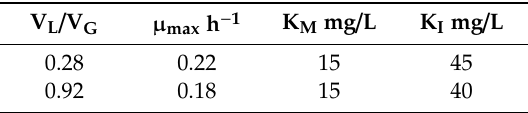
Table 3. Kinetic parameters assessed by the regression of experimental data, according to the proposed model (Equation